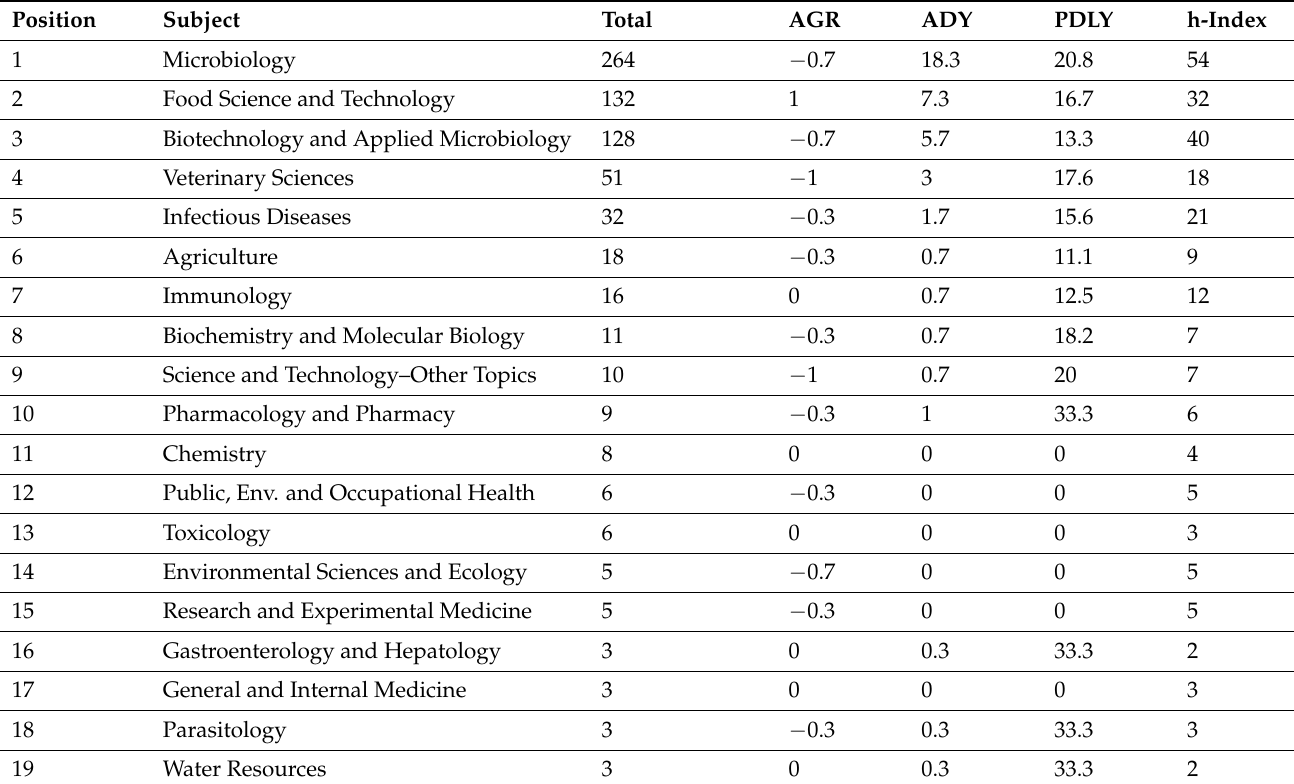
Table 2. The Average Growth Rate (AGR) and Average Documents per Year (ADY) of Arcobacter research according to subject